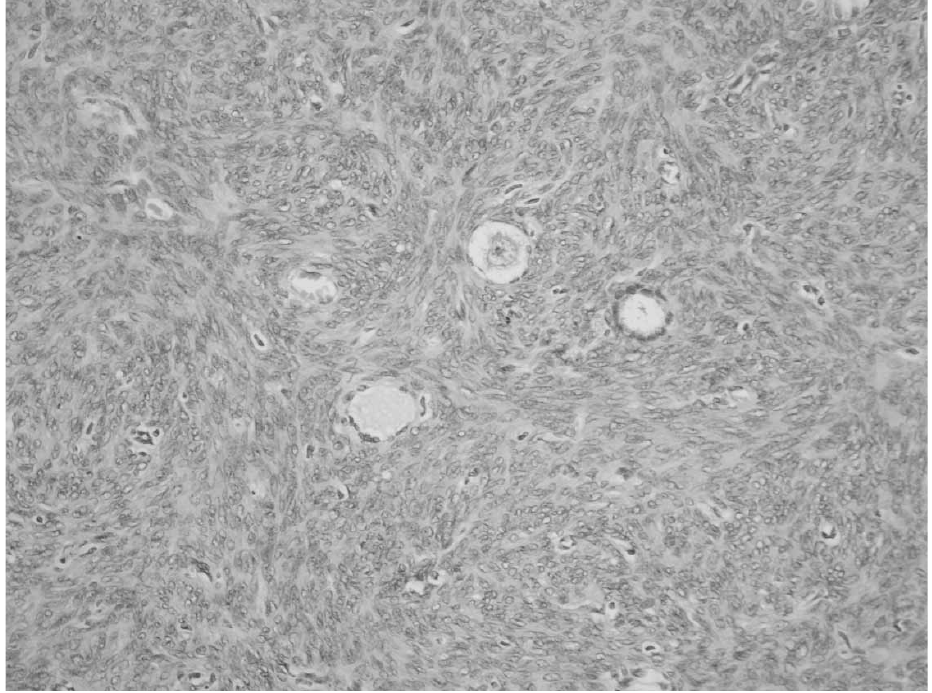
Fig. 2. The ovarian cellular cortex is composed of a spindle cell proliferation with entrapment of numerous ovarian structures consistent with ovarian fibromatosis.